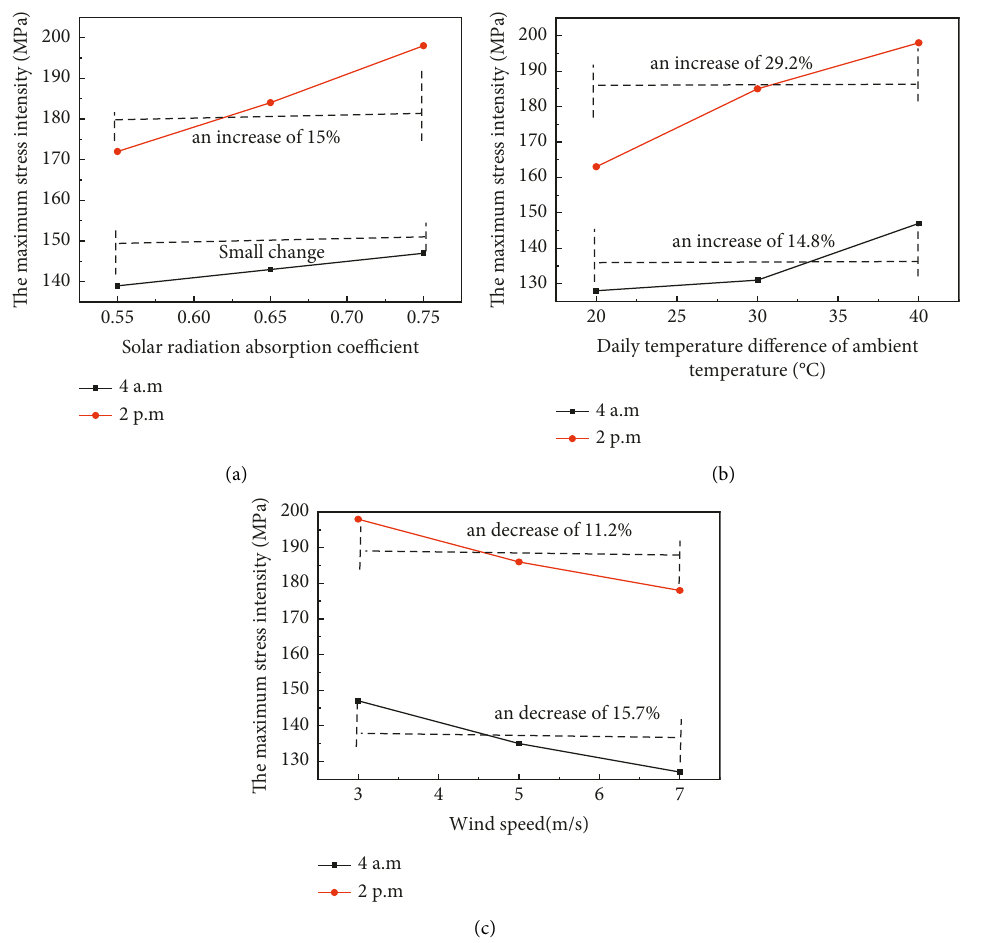
Figure 16: The maximum stress strength intensity of the steel tube: (a) influence of solar radiation absorption coefficient, (b) influence of daily ambient temperature difference, and (c) influence of wind